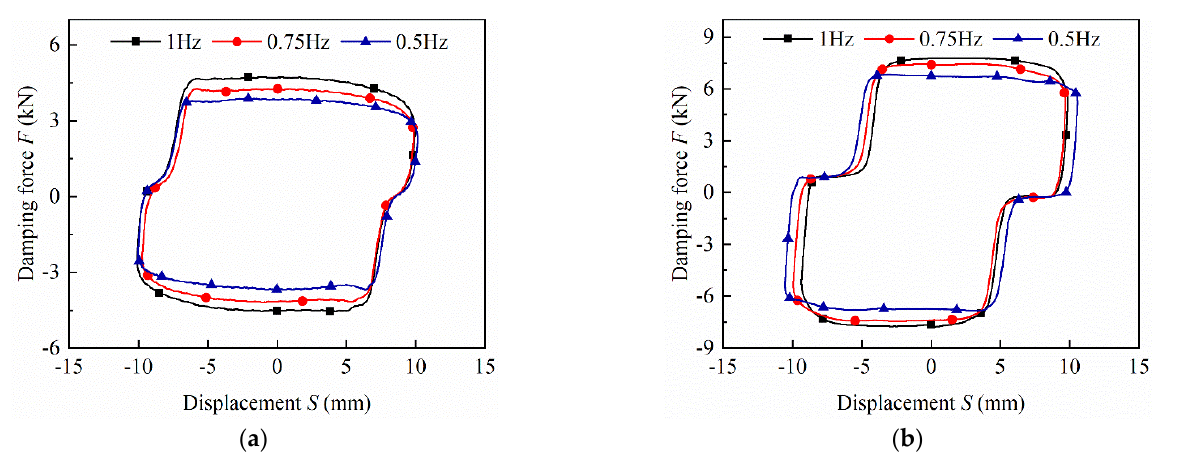
Figure 18. Damping force with amplitude of 10 mm: ( a ) initial; ( b ) optimal.